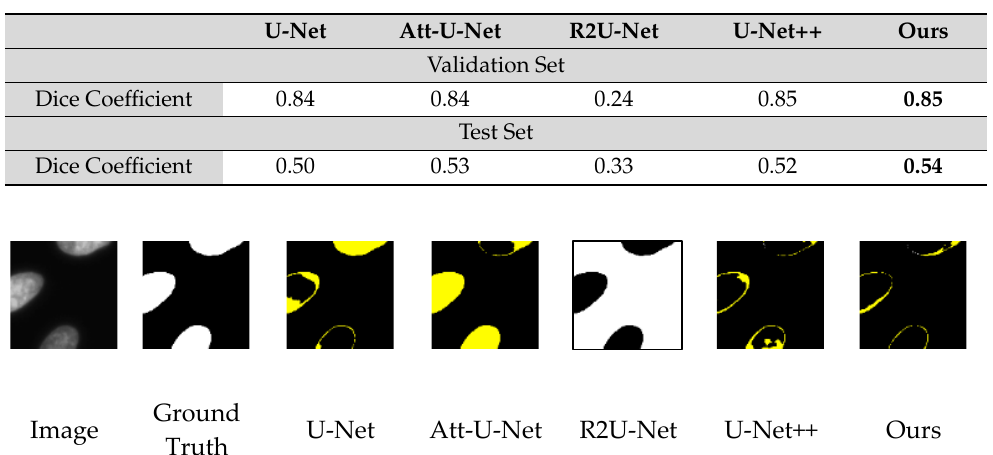
Figure 7. The segmentation results using different models without the C3S for a sample image of the 2018 DSB sub-dataset. The white pixel represents FP (false positive), while the yellow pixel represents FN (false negative). ( a ) Image; ( b ) Ground Truth; ( c ) U-Net; ( d ) Att-U-Net; ( e ) R2U-Net; ( f ) U-Net++; ( g ) Ours. Table 2. The test results of different segmentation models with C3S in the training phase.